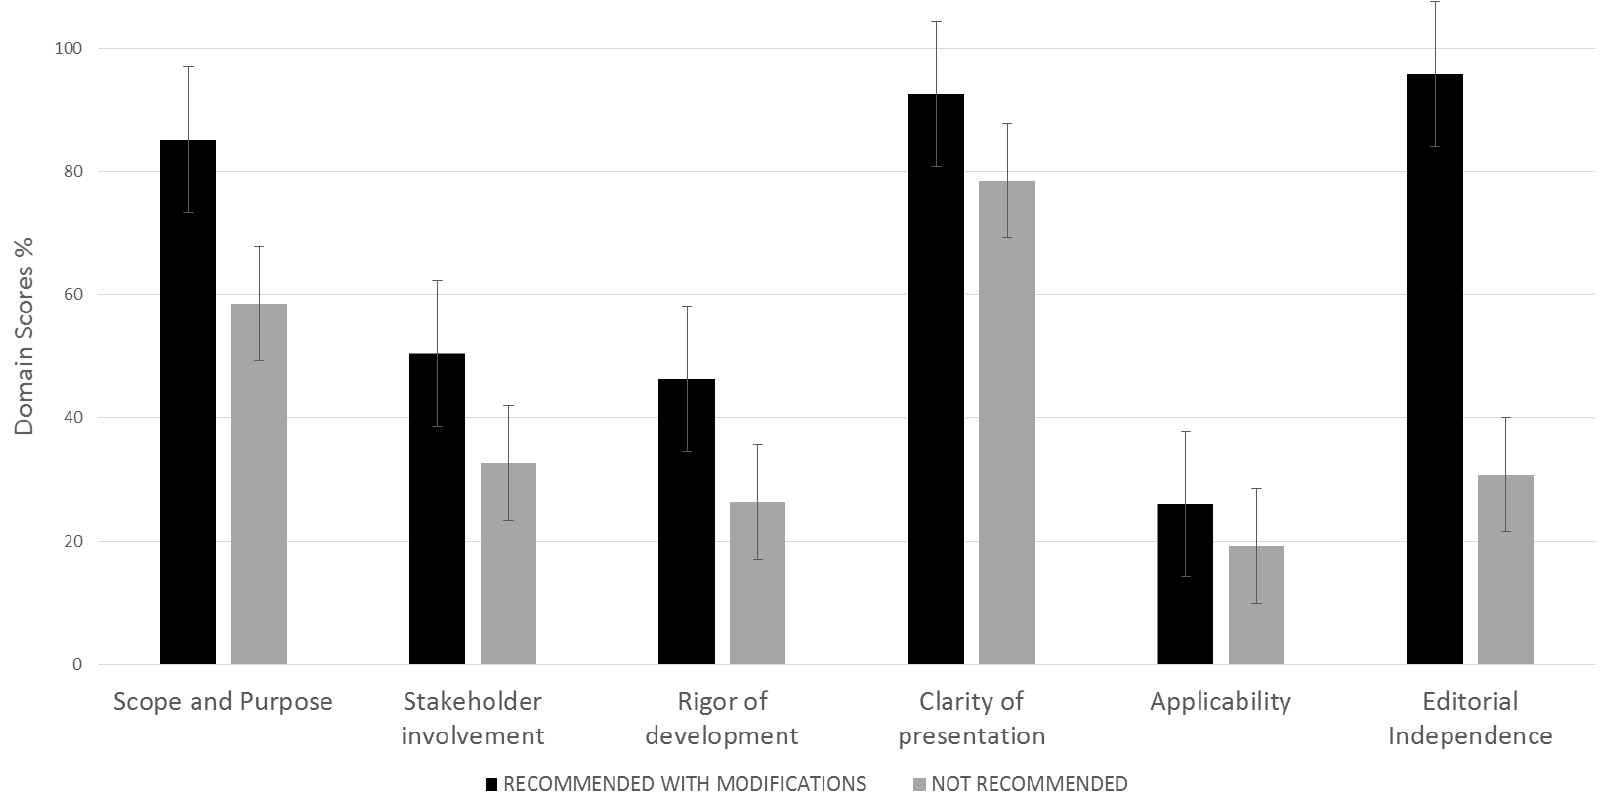
Figure 1. Average quality score of each domain between recommended with modifications and not recommended guidelines.